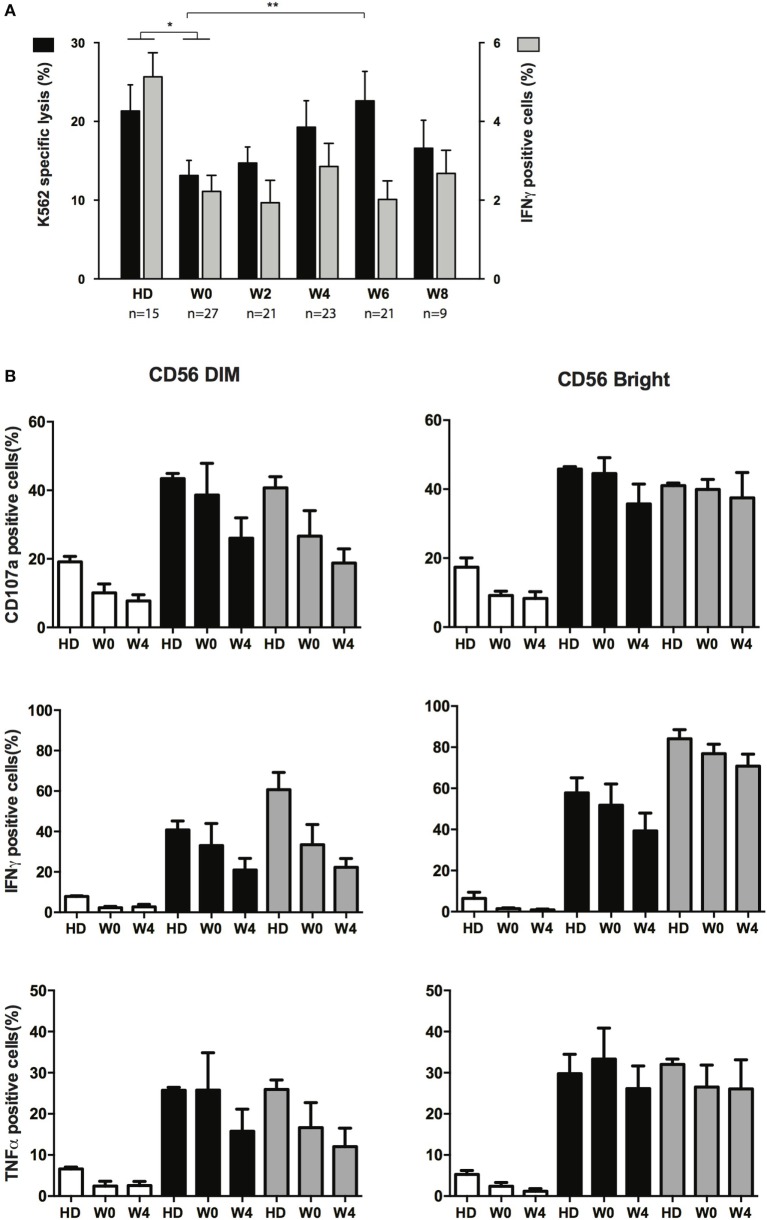
Effector functions of NK cells following chemotherapy. (A) Specific lysis of target cells (black bars, left axis) and intracellular production of IFN-γ (gray bars, right axis) after interaction between NK from healthy donors (HDs) or patients at the indicated time points and K562 cells. Histogram represents mean and bars represent SEM. (B) Effect of cytokine priming on degranulation and production of IFN-γ and TNF-α upon interaction with K562 cells. NK cells from HDs (n = 3) and patients (n = 5) at the indicated time points were treated overnight with medium only (white bars), IL-2 + IL-15 (black bars) or IL-12 + IL-18 (gray bars). Cells were then washed and incubated for 4 h with K562 cells. Effector responses were analyzed as indicated in the Section “Materials and Methods.” The figure depicts CD56dim (left) and CD56bright (right) identified with the flow cytometry analysis software.